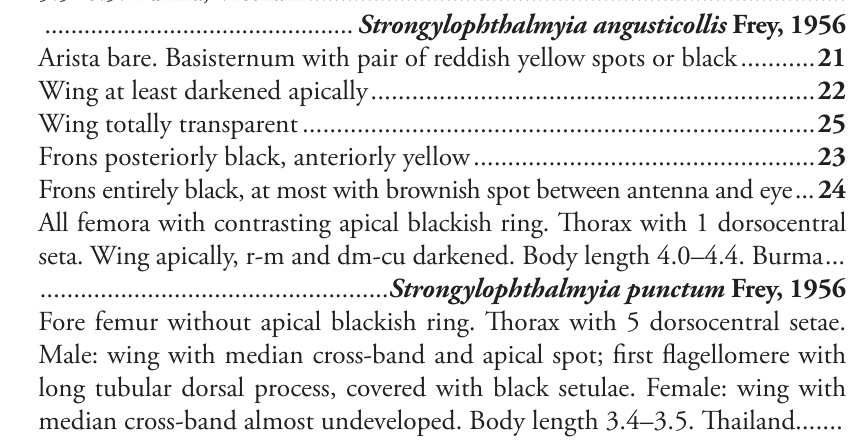
– 21 – 22 – Frons entirely black, at most with brownish spot between antenna and eye ... 24 23 All femora with contrasting apical blackish ring. Thorax with 1 dorsocentral seta. Wing apically, r-m and dm-cu darkened. Body length 4.0–4.4. Burma ... – Fore femur without apical blackish ring. Thorax with 5 dorsocentral setae. Male: wing with median cross-band and apical spot; first flagellomere with long tubular dorsal process, covered with black setulae. Female: wing with median cross-band almost undeveloped. Body length 3.4–3.5. Thailand....... 24 Wing darkened apically. Legs yellow, only hind femur with preapical brown ring. Abdomen entirely black, basisternum without yellow spots. Body length – Wing with median cross-band and apical spot. Mid and hind femora with preapical brown ring. Hind tibia with subbasal brownish ring, occupying one third of tibia. Abdomen black, tergite 4 yellowish laterally, tergite 5 and 6 totally yellowish. Basisternum with a pair of yellow spots (Fig. 2e). Male unknown. Female body length 3.5–3.6. Vietnam (Figure 2) ......................... 25 Face yellow. Frons entirely black. Palpus bicoloured: yellowish, darkened in basal half on anterior margin (Fig. 3c, d). Male unknown. Female body